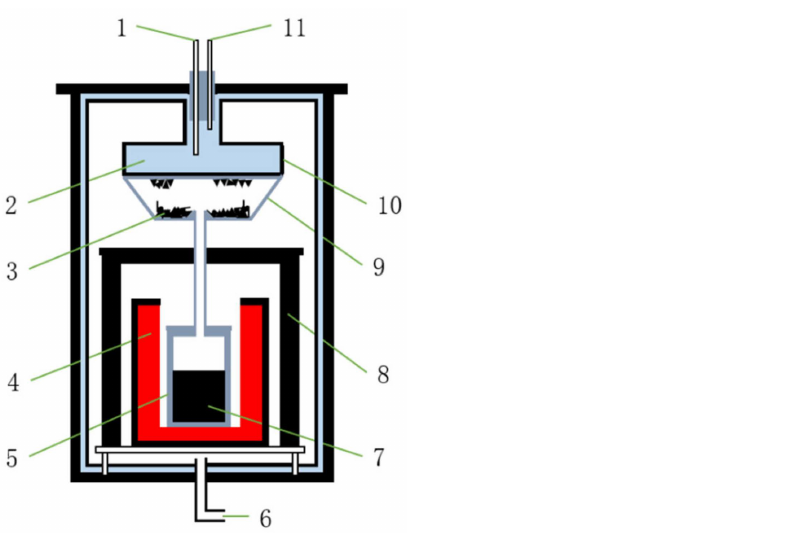
Figure 4. A schematic diagram of vacuum furnace structure: 1, water inlet; 2, cooling water; 3, condensate; 4, heating material; 5, graphite crucible; 6, connected to the vacuum pump; 7, raw materials; 8, insulation materials; 9, evaporating utensils; 10, condenser; 11, water outlet.